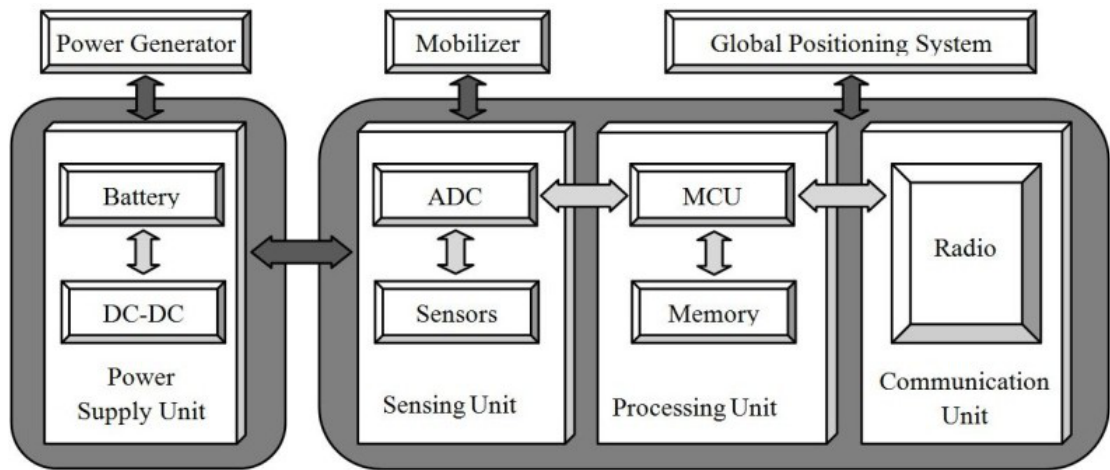
Figure 1. The structure of a typical wireless sensor node